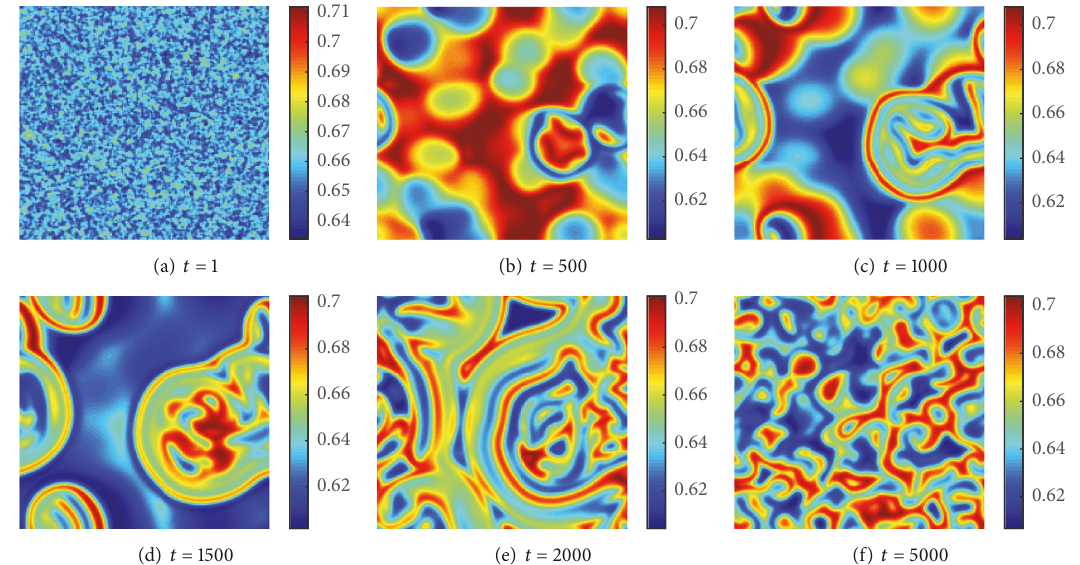
Figure 3: Pattern formation resulting from spatially symmetry breaking on invariant closed curves and starting with stochastic initial condition. 𝑎 = 1.63, 𝑏 = 0.1, 𝑐 = 0.32, 𝑑 = 0.22, 𝐷 1 = 0.6, 𝐷 2 = 1.2, 𝜏 = 5.1, 𝛿 = 10, and 𝑛 = 200.